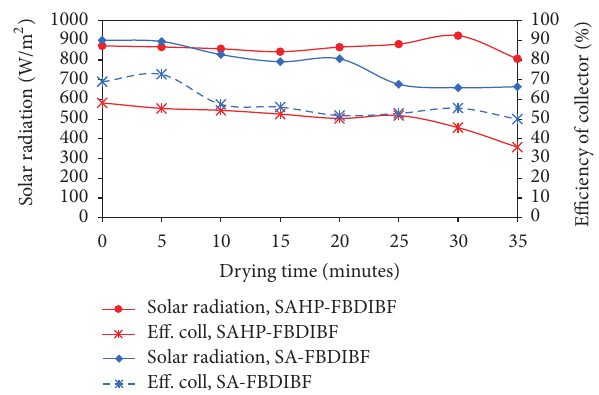
Figure 9: The variation of solar radiation and efficiency of collector with drying